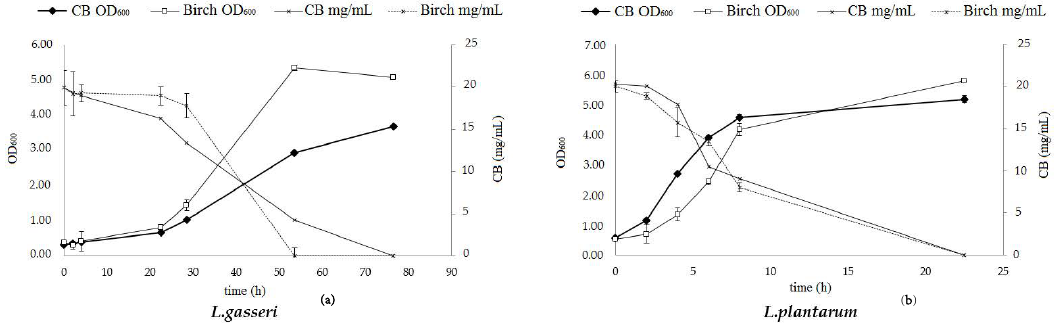
Figure 9. Growth curve and carbohydrate consumption of ( a ) L. gasseri and ( b ) L. plantarum grown anaerobically, at 36 ◦ C, on MRS culture media supplemented with 2% (w / v) cellobiose and with birch hydrolysate at an initial concentration corresponding to 2% (w / v) cellobiose. Table 4. Fermentation metabolites (mg / mL) of Lactobacilli strains upon growth on pure cellobiose, birch and spruce COS-rich hydrolysates. No significant amounts of formic or butyric acid were detected. L. gasseri L. plantarum Cellobiose Birch Hydrolysate Cellobiose Birch Hydrolysate 0 h 77 h 0